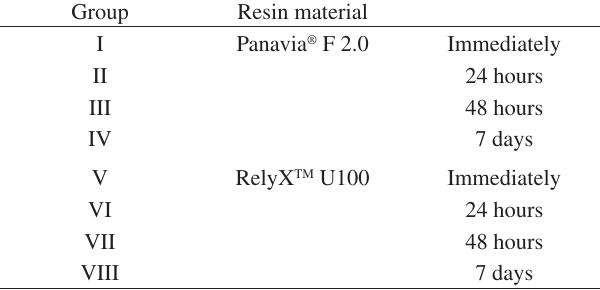
Table 2. Groups performed to this